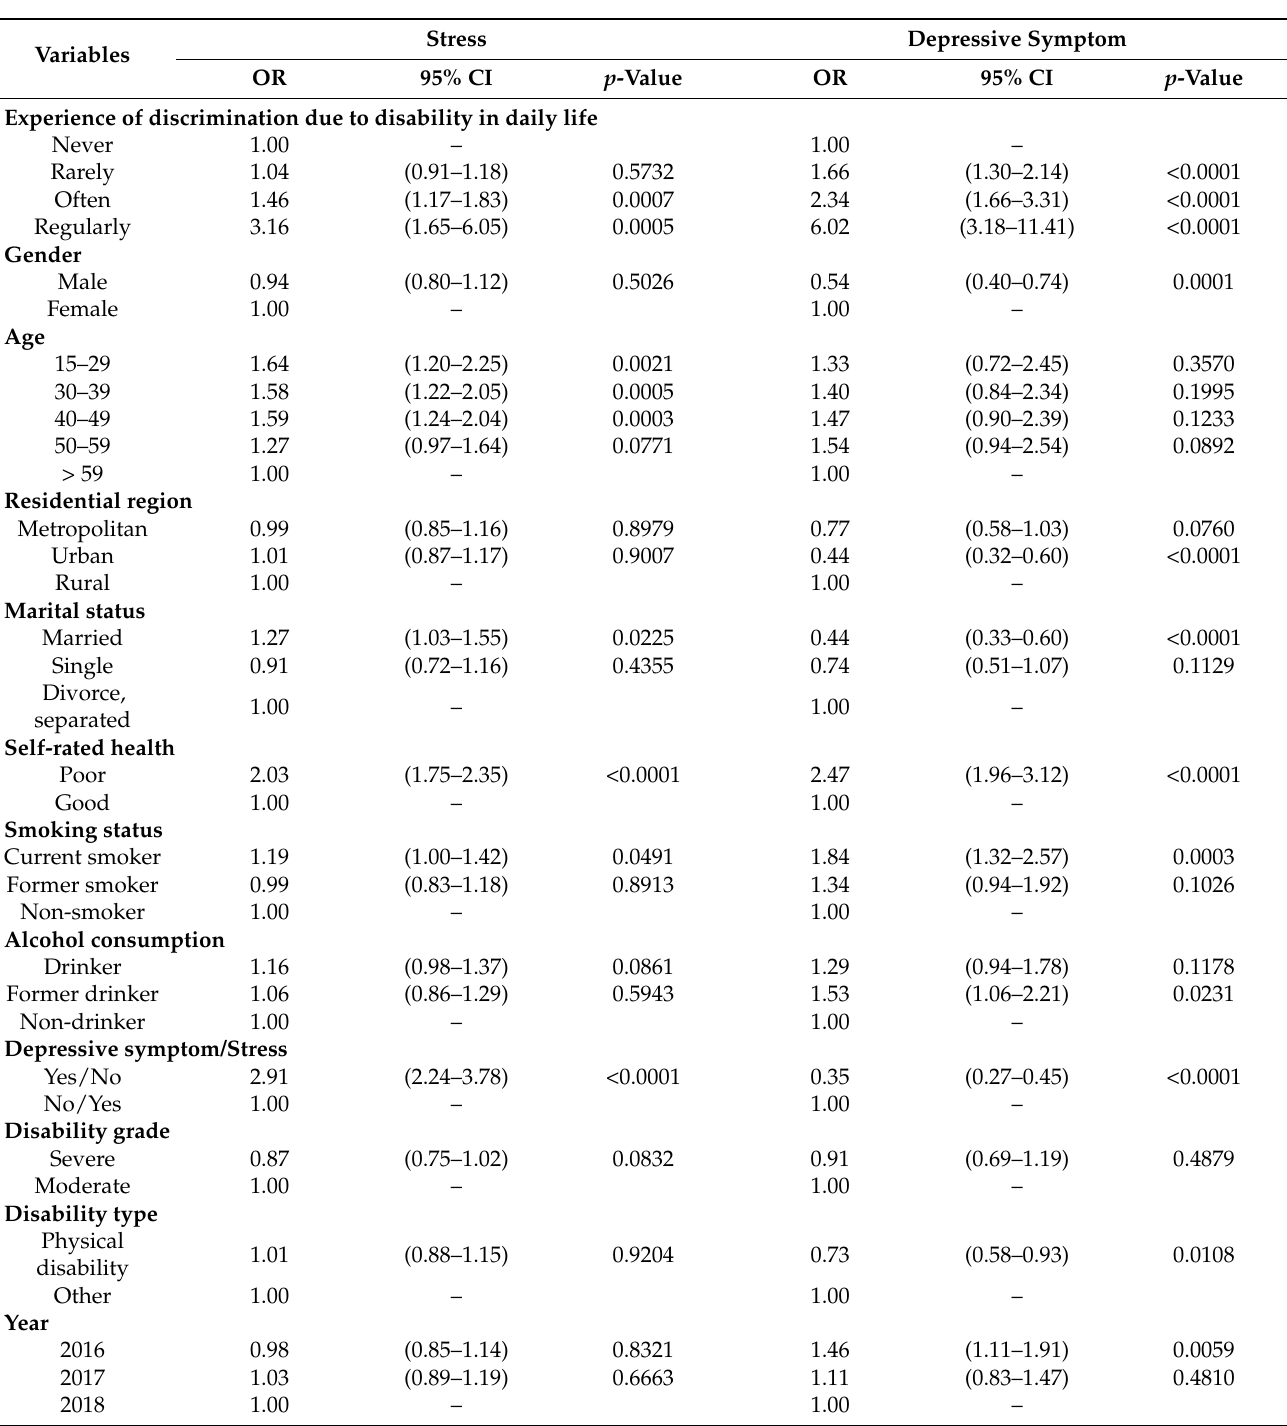
Table 2. Association between experience of discrimination due to disability in their daily life and stress/depressive